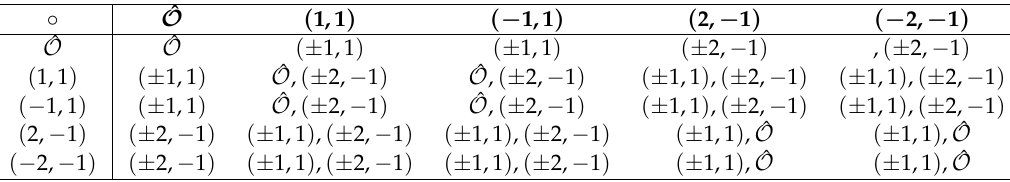
(cid:0) ( f Q Z ( − 1 ) ,0 5